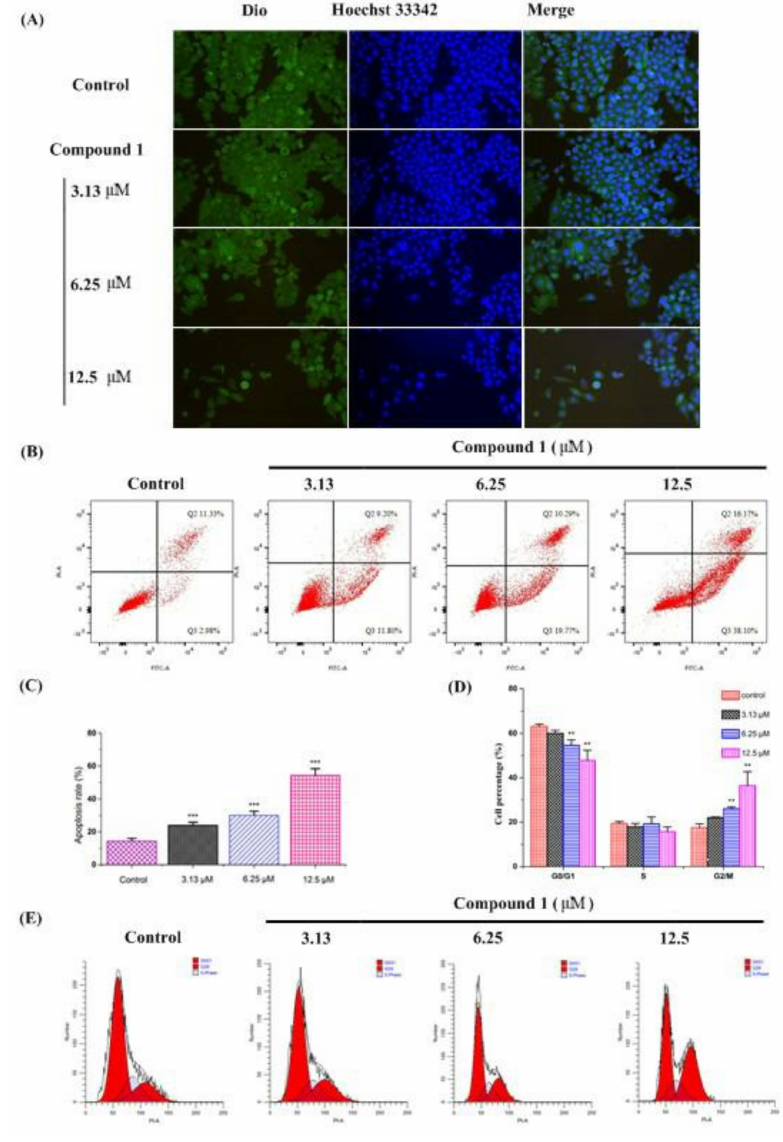
Figure 4. Effects of compound 1 on cell morphology, cell apoptosis, and cell cycle of HepG2 Cells in vitro. HepG2 cells were seeded in 12–well plates. After 24 h incubation, cells were incubated with compound 1 for another 48 h. Cell morphology assay ( A ): The cells were washed with PBS, fixed by paraformaldehyde, washed with PBS, stained with Dio, washed with PBS, stained with Hoechst 33342, and washed with PBS. The cells were then observed and photographed using a fluorescence microscope. Cell apoptosis ( B , C ) and cycle ( D , E ) assay: In the cell apoptosis assay, all the cells were collected, and 100,000 cells were taken and incubated with Annexin V–FITC and PI for 20 min at room temperature without light. In the cell cycle assay, all the cells were collected and fixed with precooled 70% ethanol for 12 h at 4 ◦ C. The cells were then washed with PBS and incubated with PI for 30 min at 37 ◦ C without light. Finally, all the cells were detected using a flow cytometer. Data are presented as mean ± SD, n = 3. One way ANOVA, ** p < 0.001, *** p < 0.001, compared with control